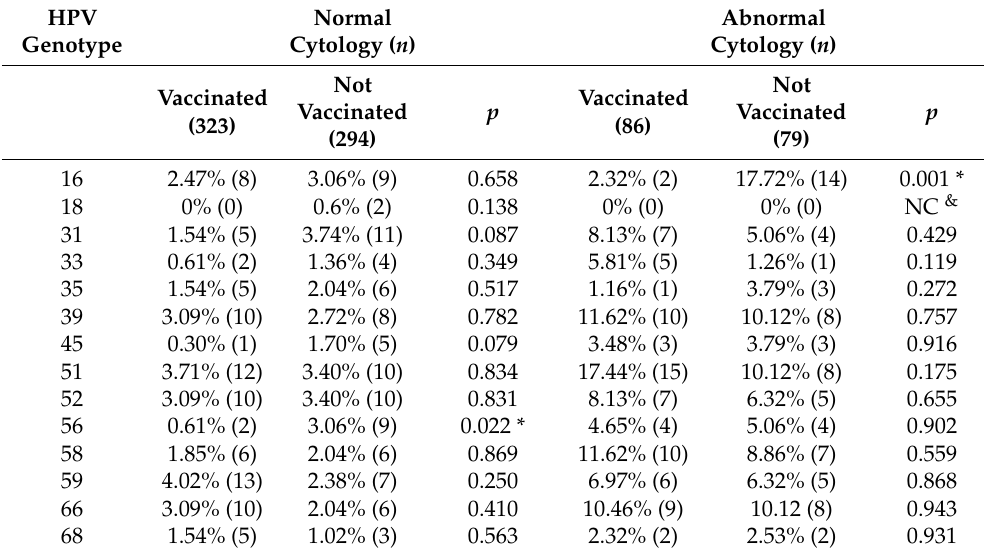
Table 7. Cytological results according to present genotype (coinfections are not individualized) and according to vaccination status. * Statistical significance. & Non-calculable.